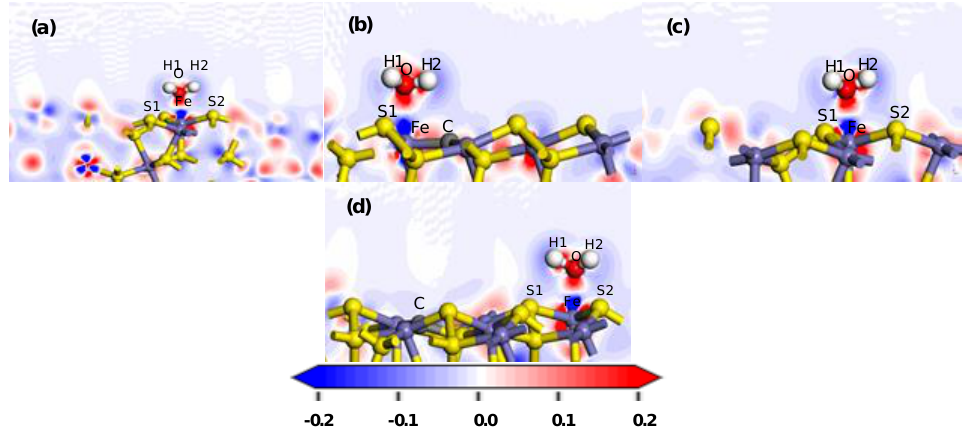
Figure 5. Charge density difference after H 2 O adsorption on the coal pyrite surface: ( a ) ideal surface; ( b ) doping-position; ( c ) ortho-position; ( d ) meta-position.